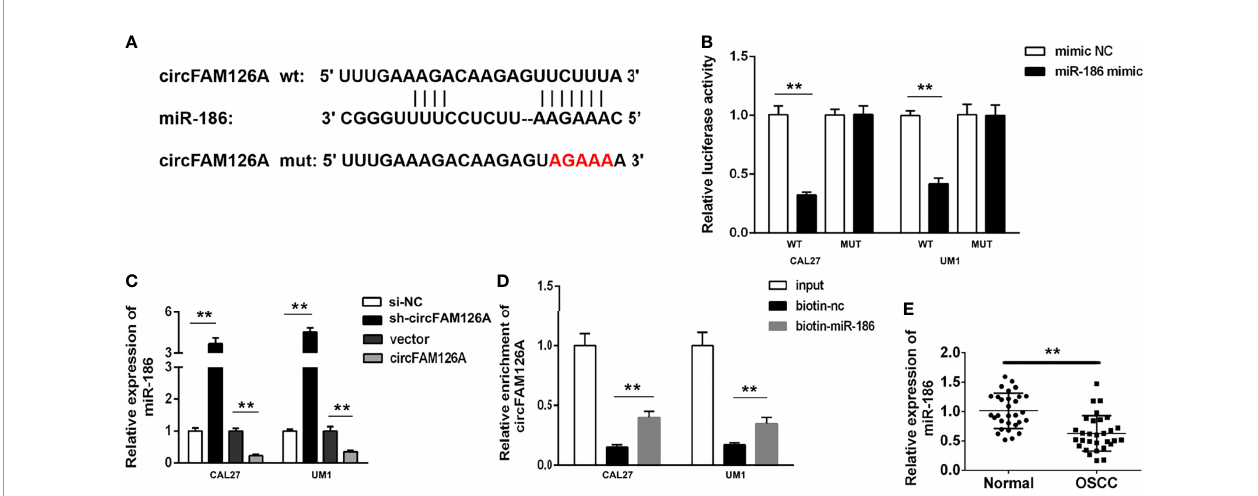
FIGURE 5 | circFAM126A acts as a sponge of miR-186 in OSCC cells. (A) The binding sites predicted by Starbase3.0. (B) The binding sites veri fi ed by dual- luciferase reporter assay. (C) The expression of miR-186 detected using qRT-PCR. (D) The interaction between circFAM126A and miR-186 determined by RNA pull- down assay. (E) Expression of miR-186 in clinical samples determined by qRT-PCR. ** P